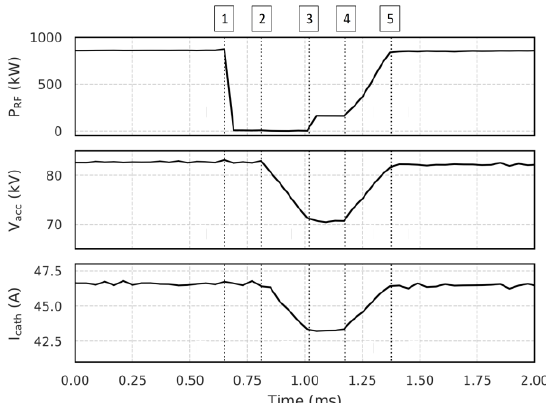
Fig. 4. Operation diagram of the mode recovery system [2]. 1) Mode loss 2) Detection of the mode loss and rapid decrease of the acceleration voltage by 10 kV. 3) Reestablishment of the gyrotron mode. 4) Rapid ramping up of the acceleration voltage to just below the nominal value. 5) Slow voltage ramp up to the nominal value.